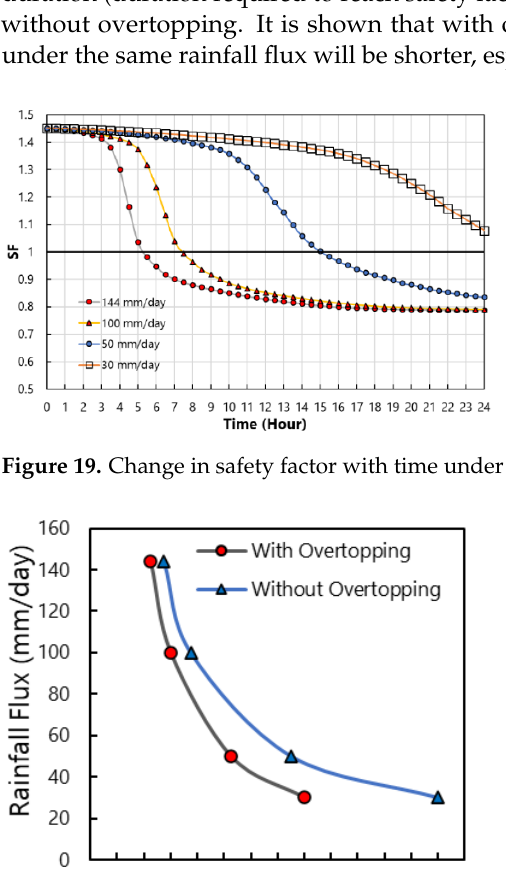
Figure 18. Slope failure after 5.5 h with a flux of 144 mm/day without overtopping.